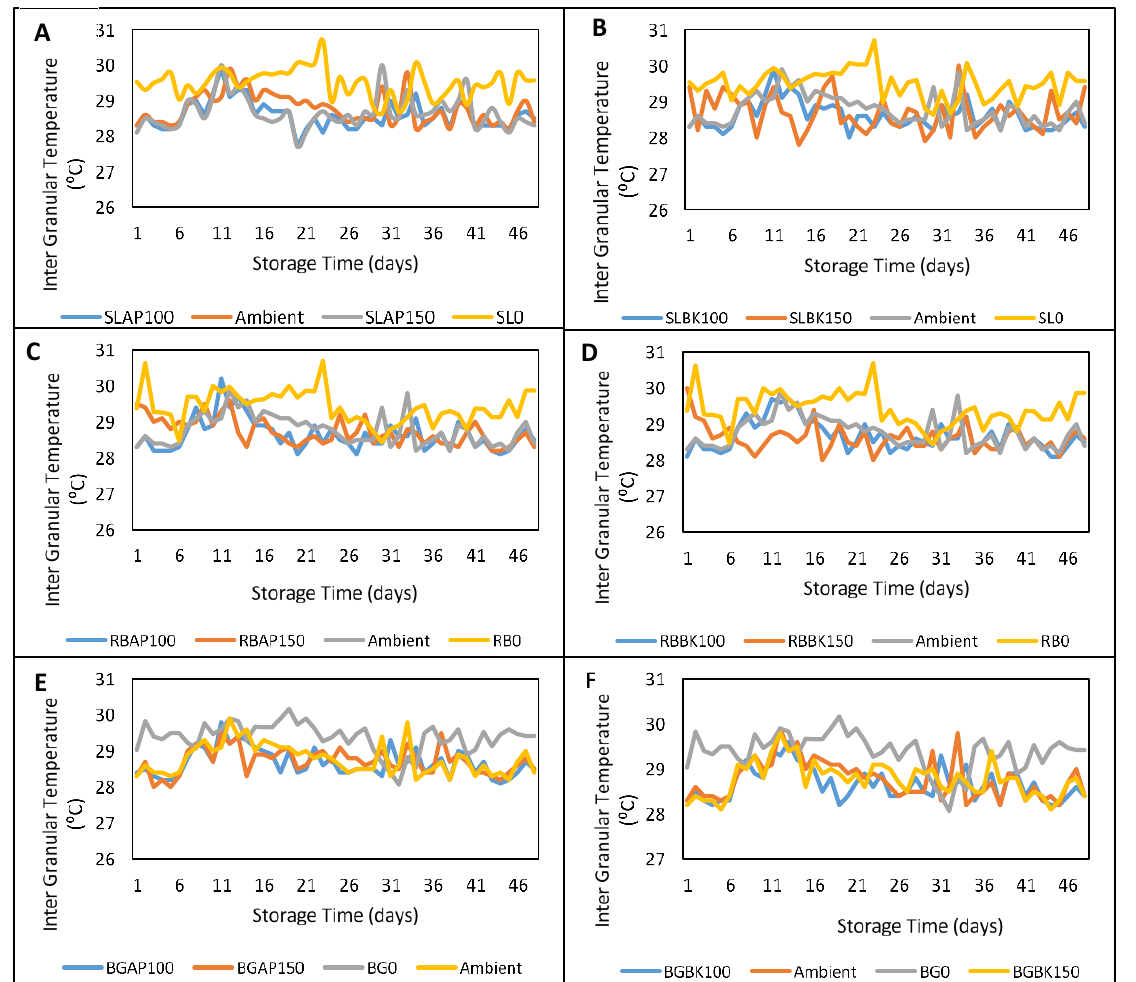
Figure 3. Intergranular temperature of the stored breadfruits for different storage methods and treatments. ( A ) Breadfruit stored in the silo and treated with aligator pepper. ( B ) Breadfruit stored in the silo and treated with bitter kola. ( C ) Breadfruit stored in the rubber and treated with aligator pepper. ( D ) Breadfruit stored in the rubber and treated with bitter kola. ( E ) Breadfruit stored in the bag and treated with bitter kola. ( F ) Breadfruit stored in the bag and treated with aligator pepper.